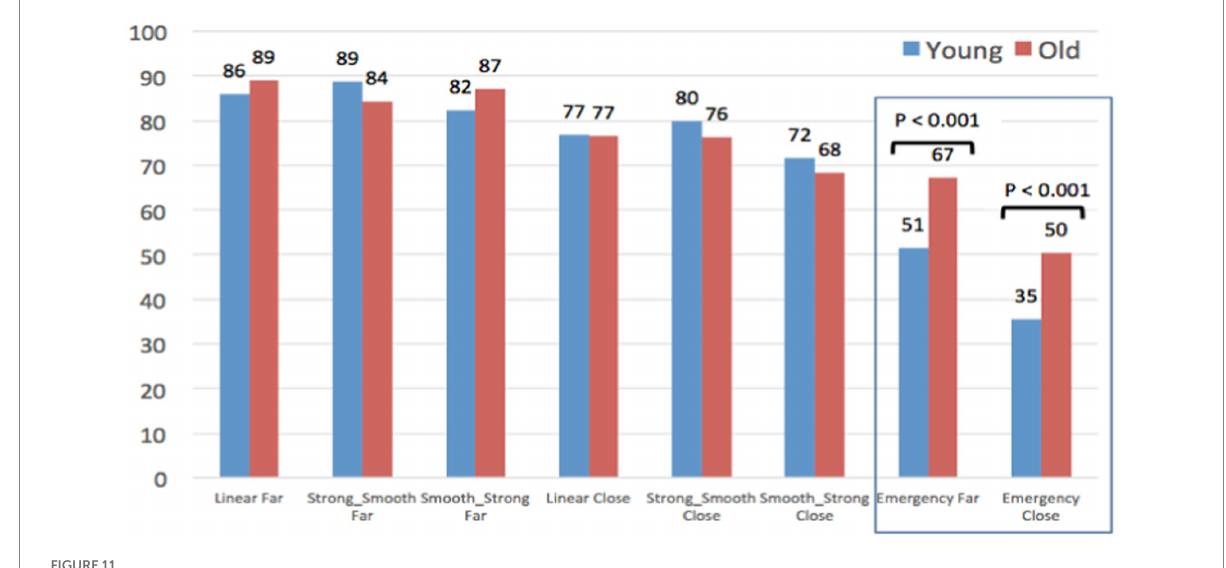
FIGURE 11 Evaluation of the safety of the AV yielding behaviors, as a